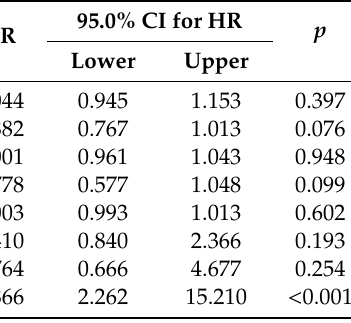
Table 3. Cox multivariate analysis for overall survival of MDS